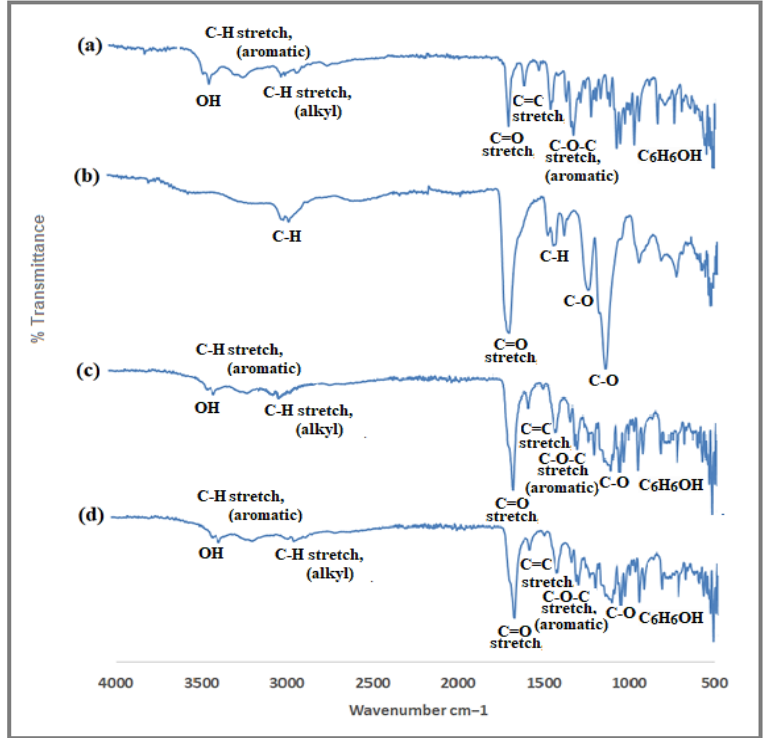
Figure 9. FTIR spectra of drug, polymer, physical mixture and nanoformulation. ( a ) Bergenin ( b ) EL 100 ( c ) lyophilized nanosuspensions ( d ) physical mixture of bergenin + E L100.